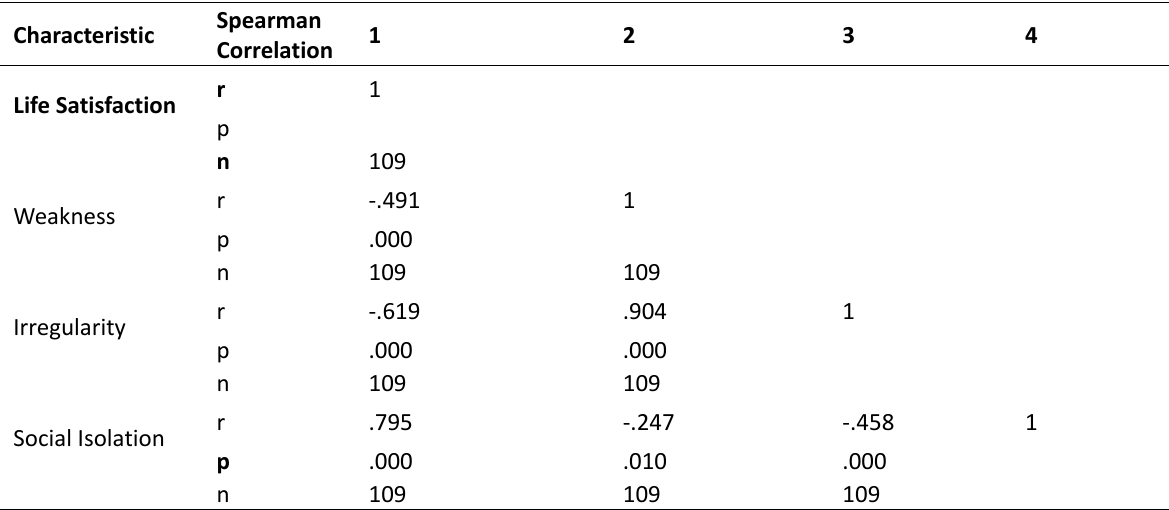
Table 6. Relation Between the Life Satisfaction and Alienation Level of Participants